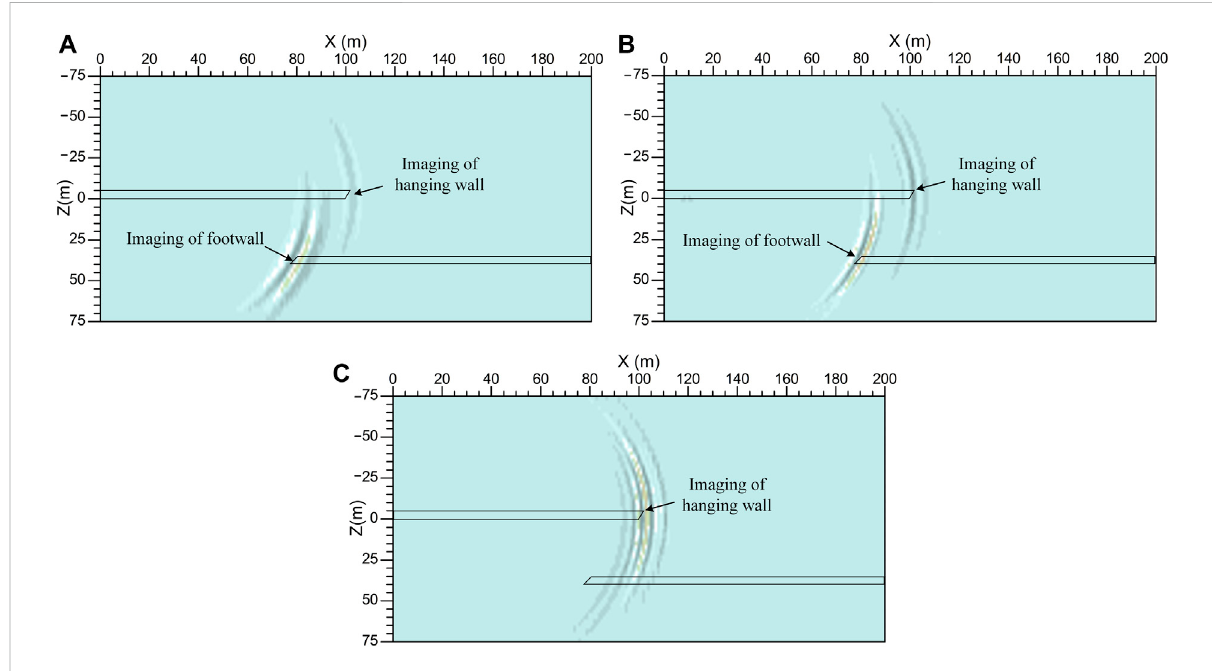
FIGURE 14 Multi-wave sections of the faulted coal seam model. (A) Section of PP waves; (B) Section of SS waves; (C) Section of channel waves.